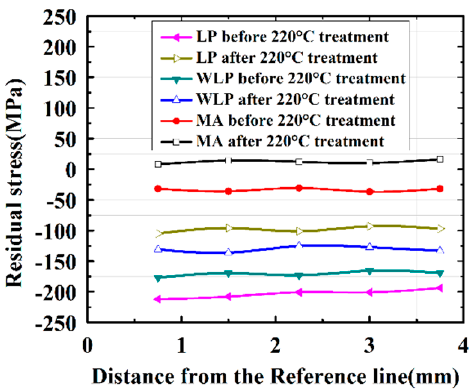
Figure 8. Surface residual stress distribution of samples after high temperature aging.